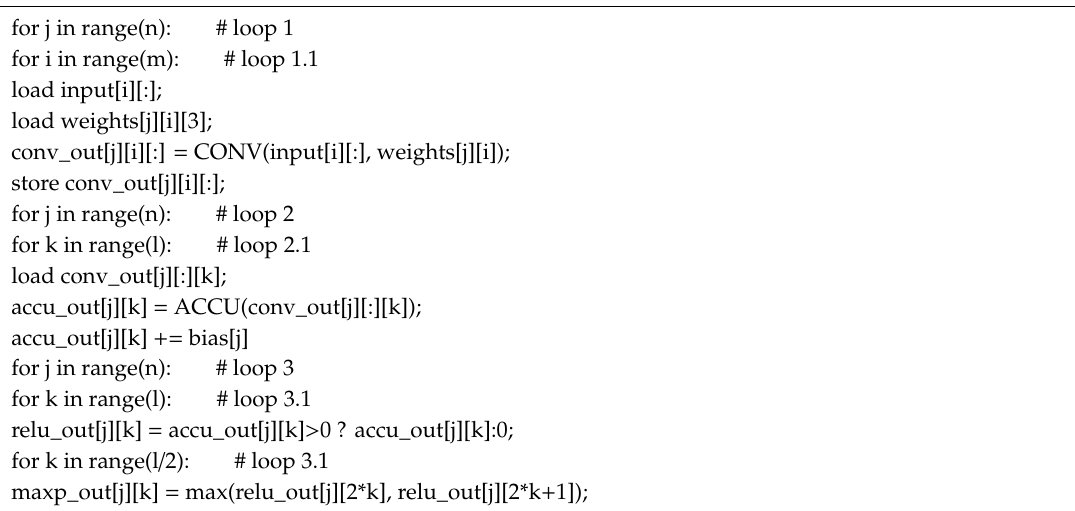
Algorithm 1. Algorithm of CONV